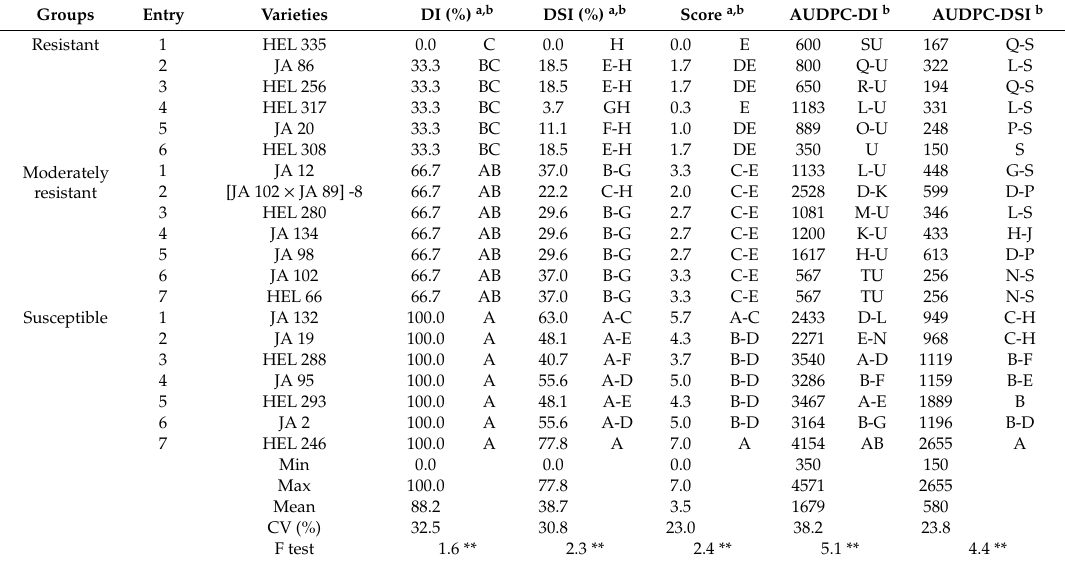
Table 3. Selected varieties of resistant, moderately resistant and susceptible Jerusalem artichoke evaluated in early rainy